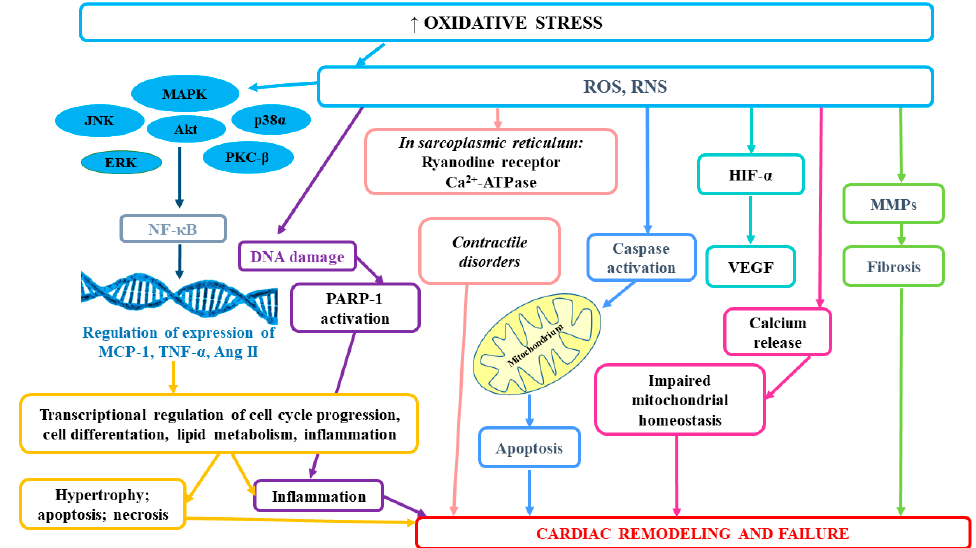
Figure 1. The role of oxidative stress in the development of cardiac remodeling and heart failure.